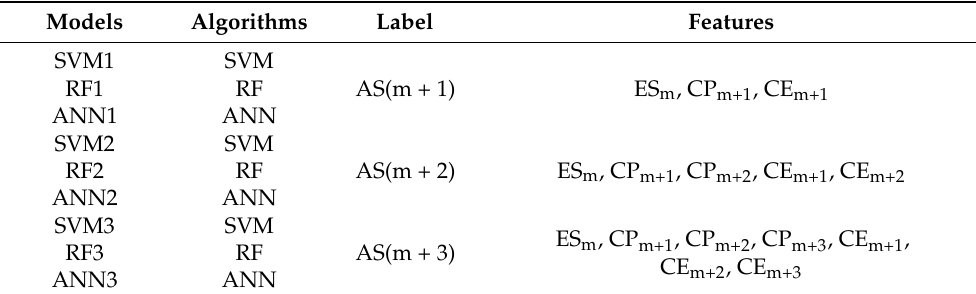
Table 4. Setup of nine dataset models for forecasting reservoir storage rates using machine learning algorithms.